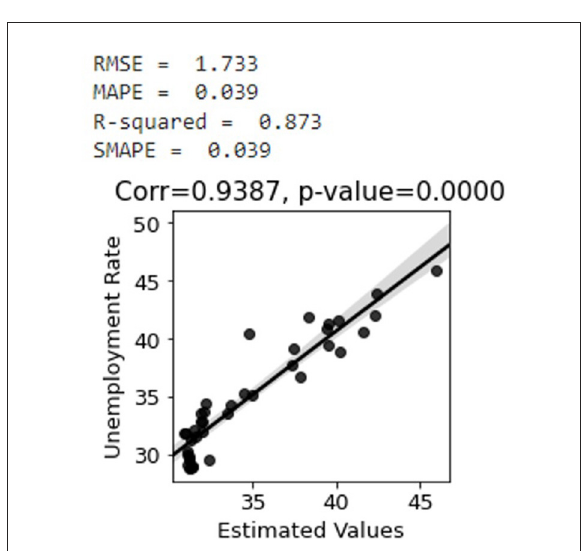
FIGURE9 Correlation between unemployment rate and estimated values of Gauteng province with 95